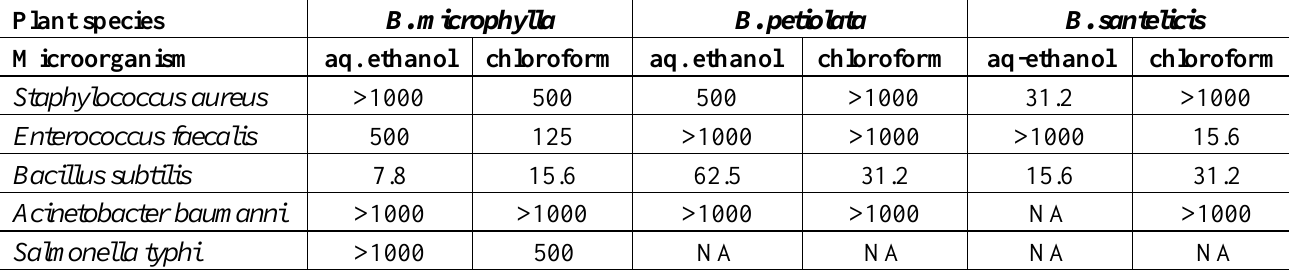
Table 2 . Minimum Inhibitory Concentration (MIC, μ g/mL) values of aqueous ethanol and chloroform extracts from three Baccharis species from Northern Chile * Plant